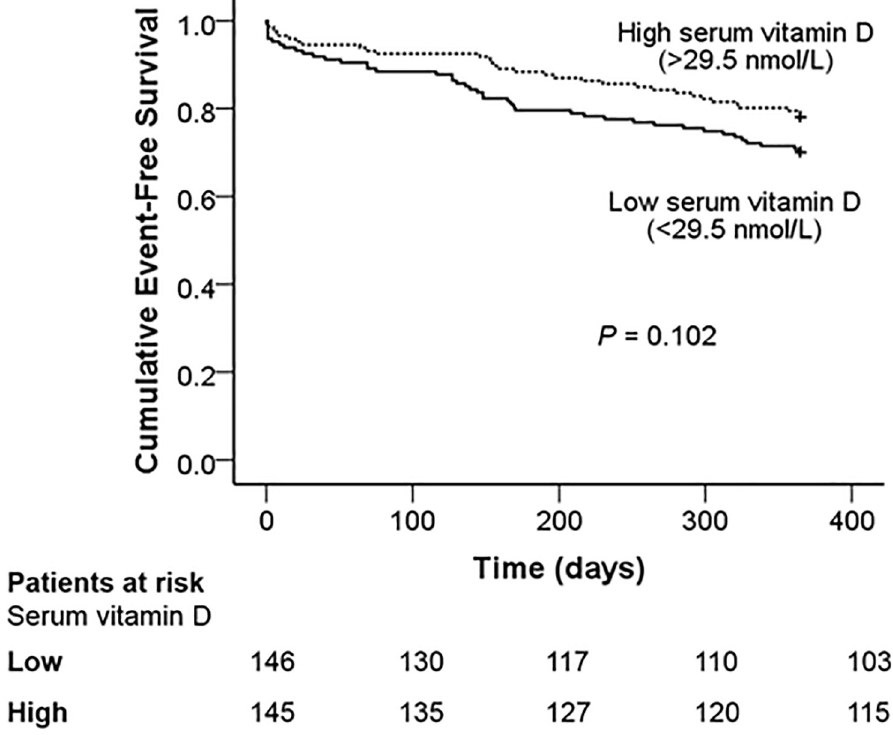
Fig 2. Cumulative event-free survival from incidence of the cumulative primary composite endpoint at 1